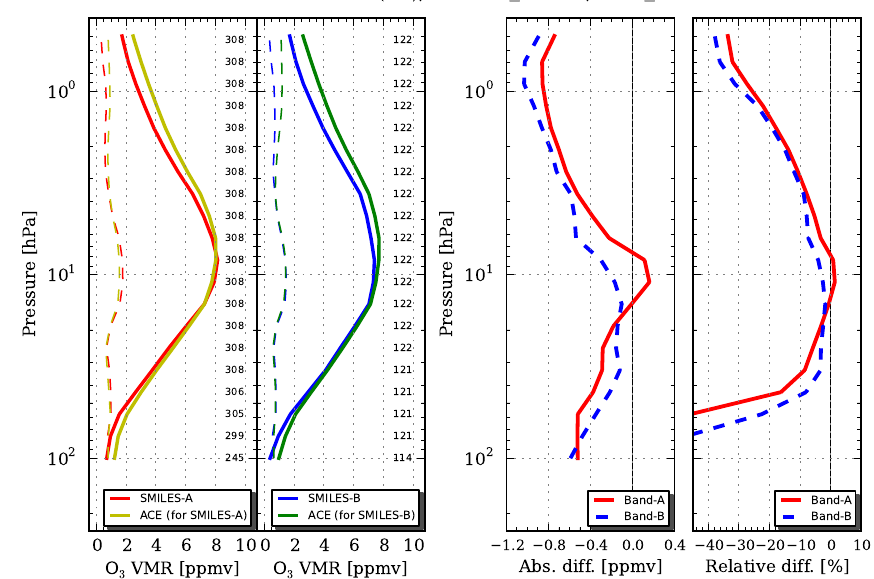
Fig. 16. Comparison between SMILES and ACE-FTS O 3 profiles. See Fig. 12 for the plot format. covered by ACE-FTS extends from 85 ◦ S to 85 ◦ N, as given in Bernath et al.